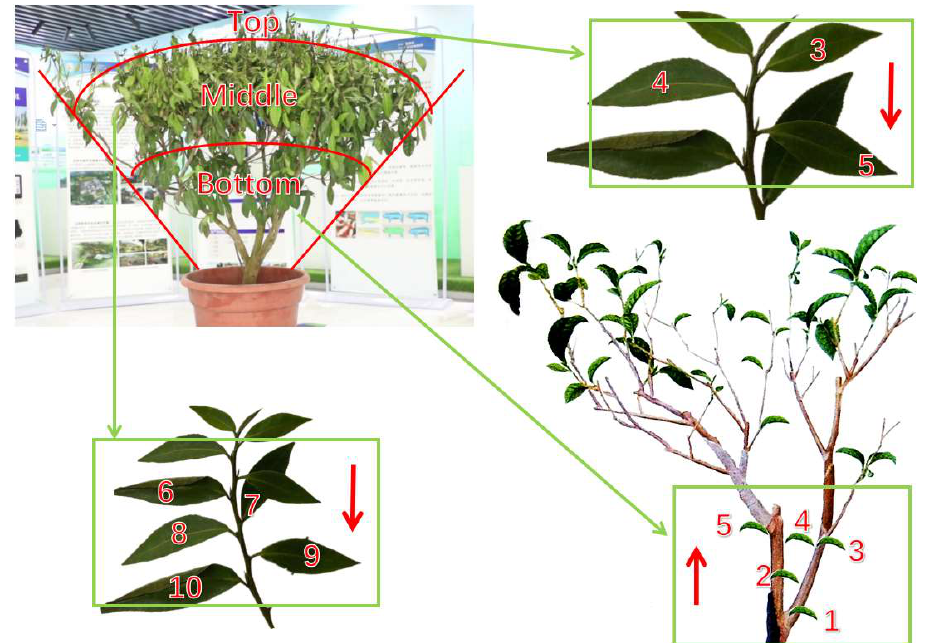
Figure 3. Data acquisition system.